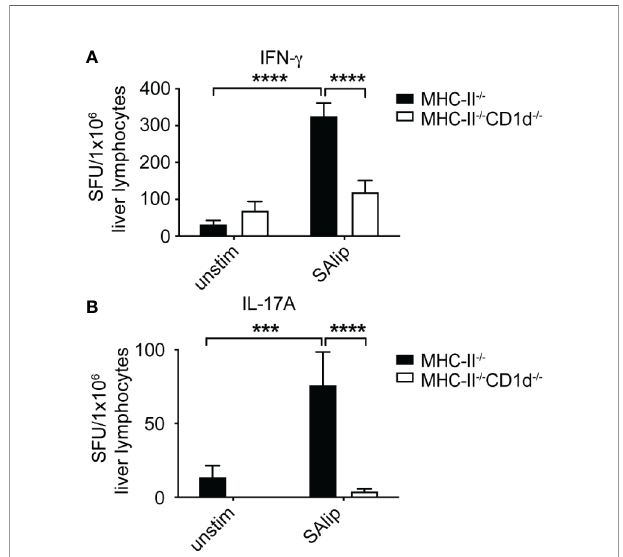
FIGURE 5 | Type II NKT cells require CD1d to recognize total SA lipids. (A, B) IFN- g (A) and IL-17A (B) ELISPOT of J a 18 -/- total liver lymphocytes collected from 4 dpi livers and co-cultured with MHC-II -/- or MHC-II -/- CD1d -/- DCs, unpulsed or